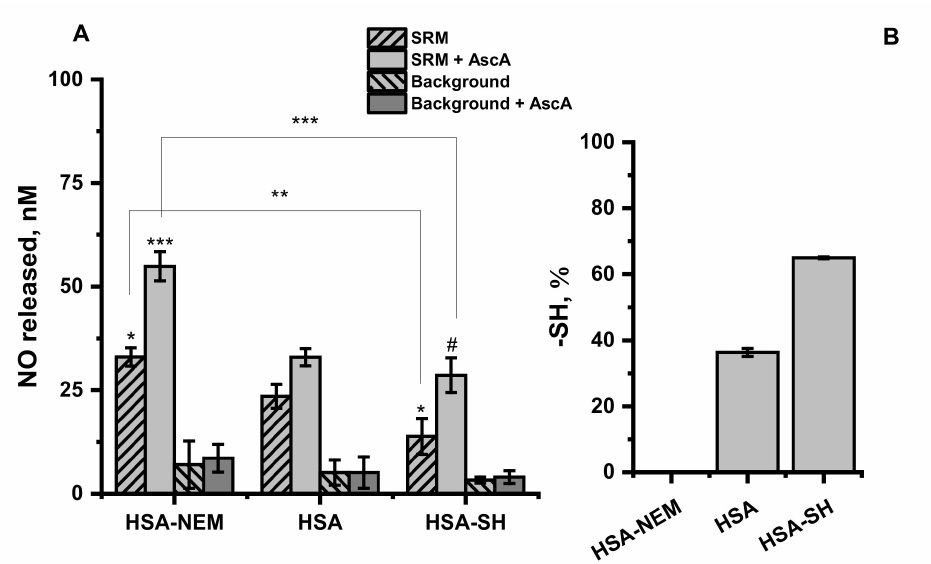
Figure 3. ( A ) The mean amount of NO released from GSNO in the presence of SRM aqueous extract =10% vol. with or without 1 µ M of ascorbic acid (AscA) in the environment of 35 µ M albumin with completely blocked thiol groups (HSA-NEM), unmodified albumin (HSA) and albumin with increased number of thiol groups (HSA-SH). Background refers to the lack of treatment with SRM extract. Measurements were performed in Tris buffer 0.1 M, pH = 7.4, T = 37 ◦ C in the presence of 5 µ M of GSNO, in the dark. Bars represent the means ± SD of three independent experiments. The values of * p < 0.05, ** p < 0.01 and *** p < 0.001 vs. controls, were considered significant; # p > 0.05. ( B ) The free thiol concentration determined in HSA-NEM, HSA and HSA-SH. Bars represent the means ± SD of three independent